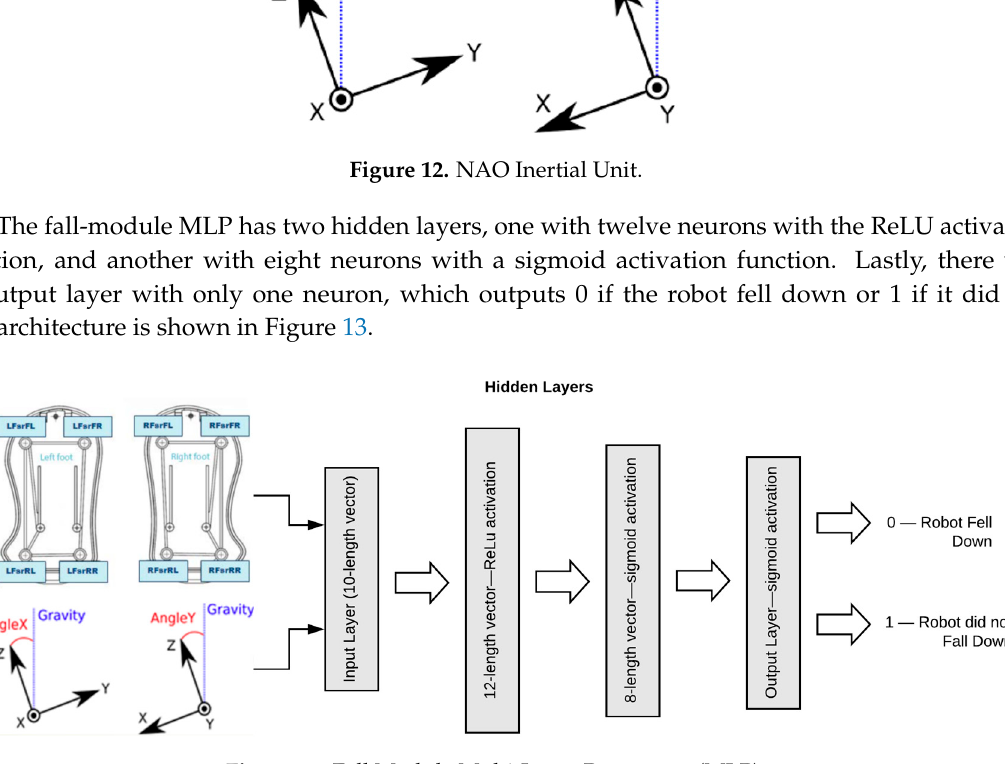
Figure 13. Fall Module Multi-Layer Perceptron (MLP).